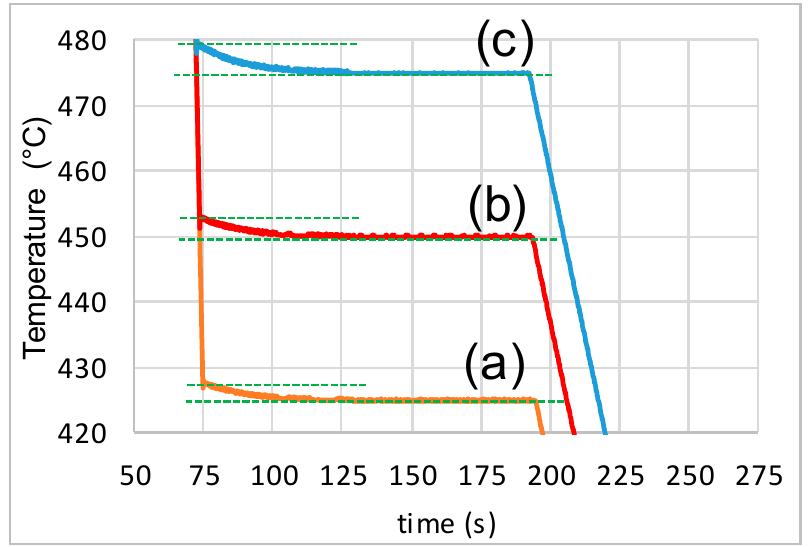
Figure 8. Δ L vs. time curves obtained experimentally during IBT for 120 s at temperature: ( a ) 425 °C, ( b ) 450 °C and ( c ) 475 °C.